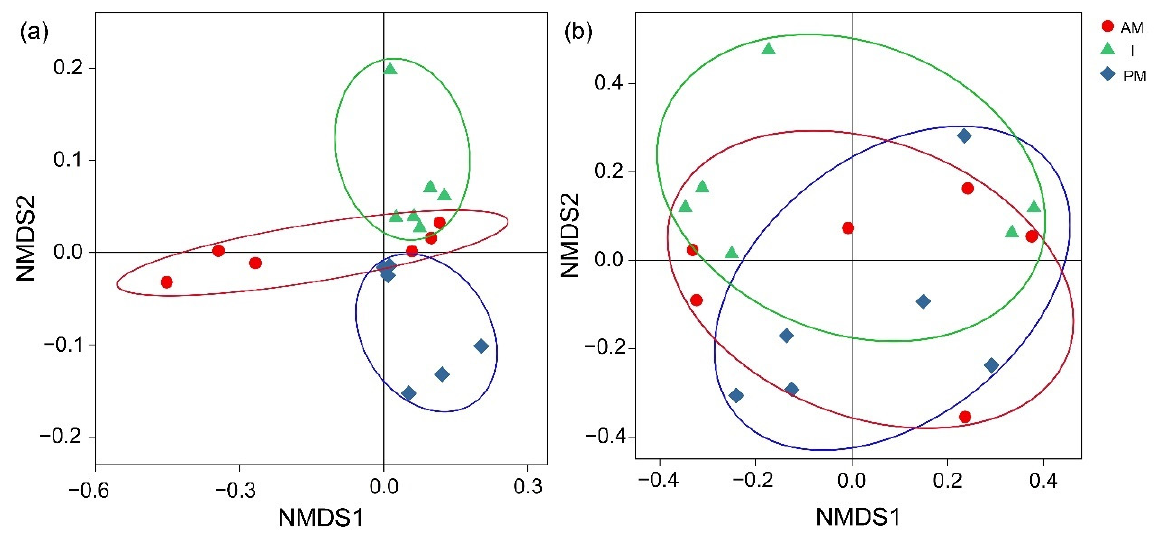
Figure A1. Effects of intercropping patterns on soil microbial (bacterial and fungal) beta diversity (NMDS) across the experimental period. AM represents areca nut monocropping; I represents areca nut intercropping with pandan; and PM represents pandan monocropping. (( a ): F = 1.9485, p = 0.09; ( b ): F = 1.969, p = 0.066, calculated by PERMANOVA).